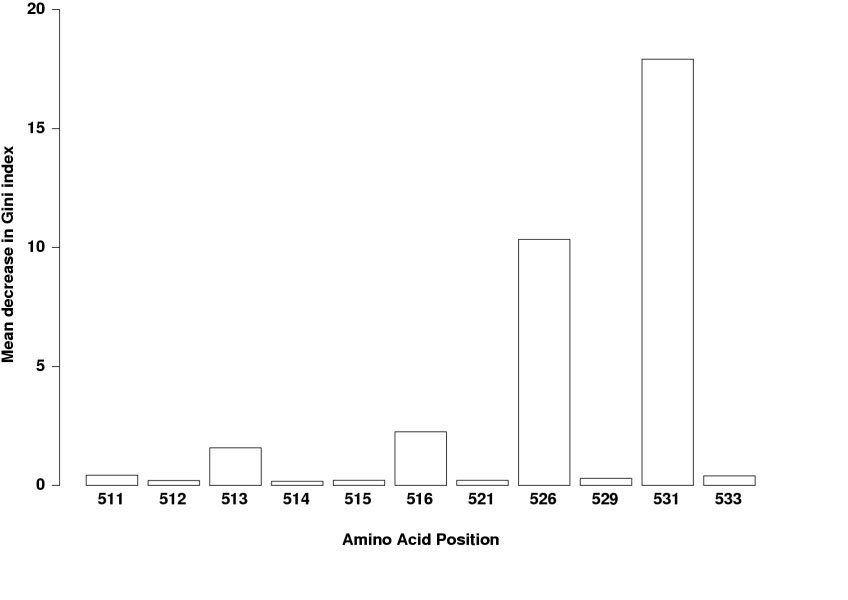
Variable importance plot from random forest classification analysis. The plot includes all polymorphic positions in the region examined, and shows the importance of each position as the decrease in the Gini index (a measure of impurity) induced by splitting the data on that position averaged over all trees (higher values are more important). The plot for regression analysis is very similar (not shown).